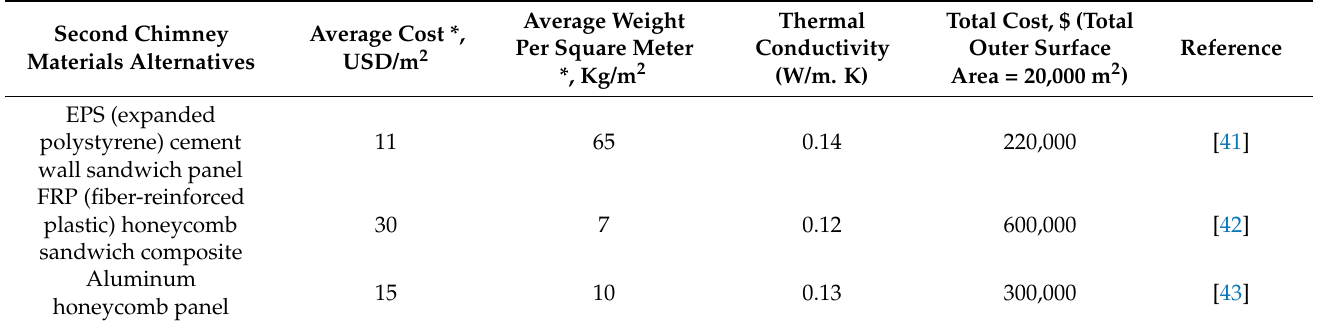
Table 7. Cost of different alternatives for the EC structure. * Average cost and weight per square meter, as calculated from different worldwide